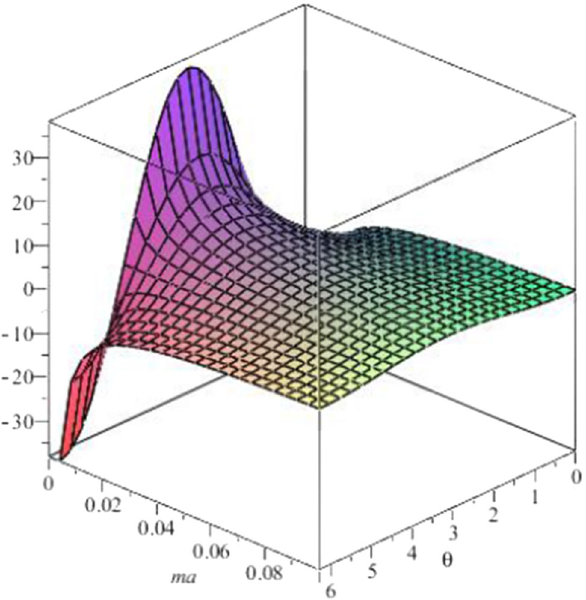
Fig. 4 Plot for the torque τ CT /( m σ V x ) in Eq.